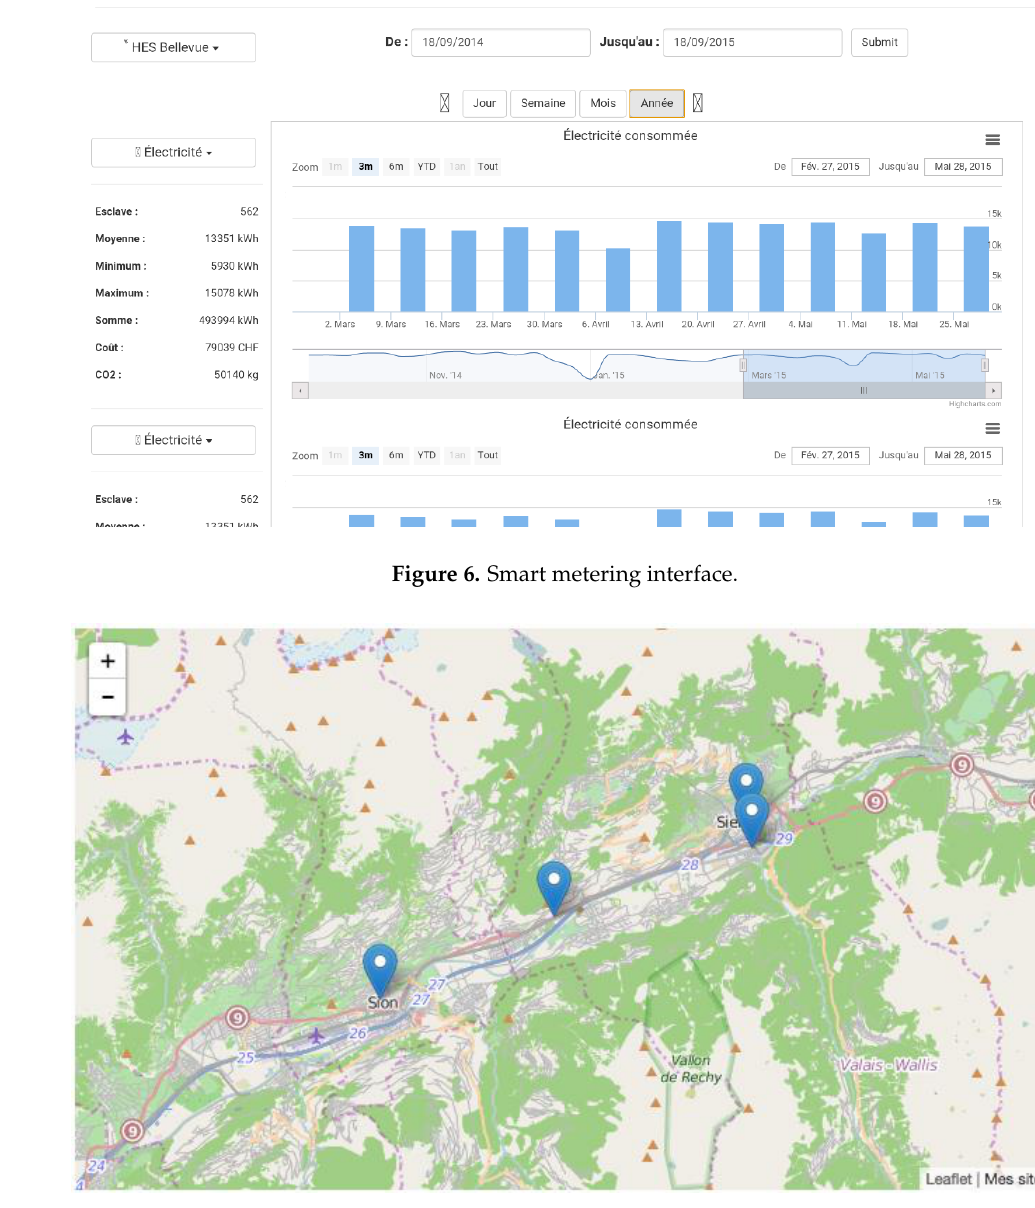
Figure 7. End-users geolocalised buildings.